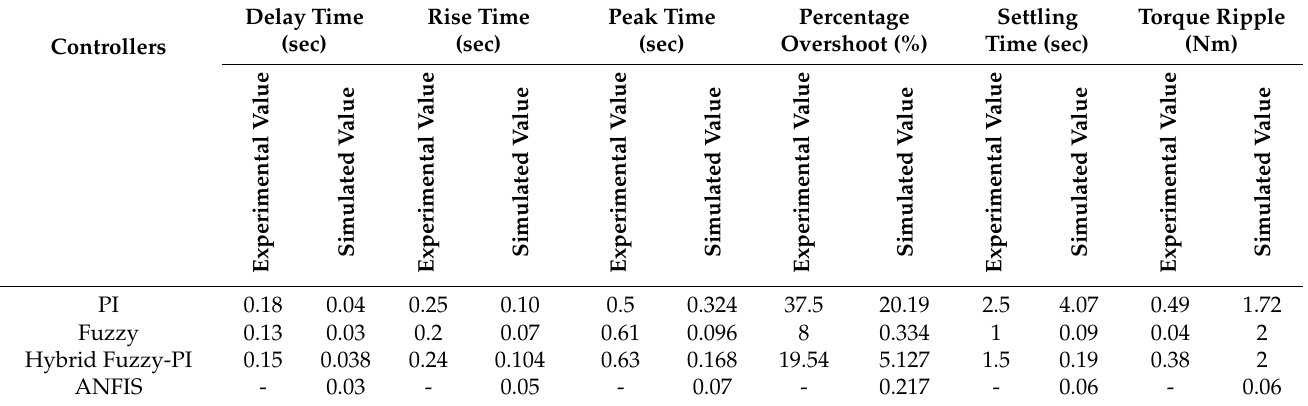
Table 9. Comparison of different controllers (Simulation and